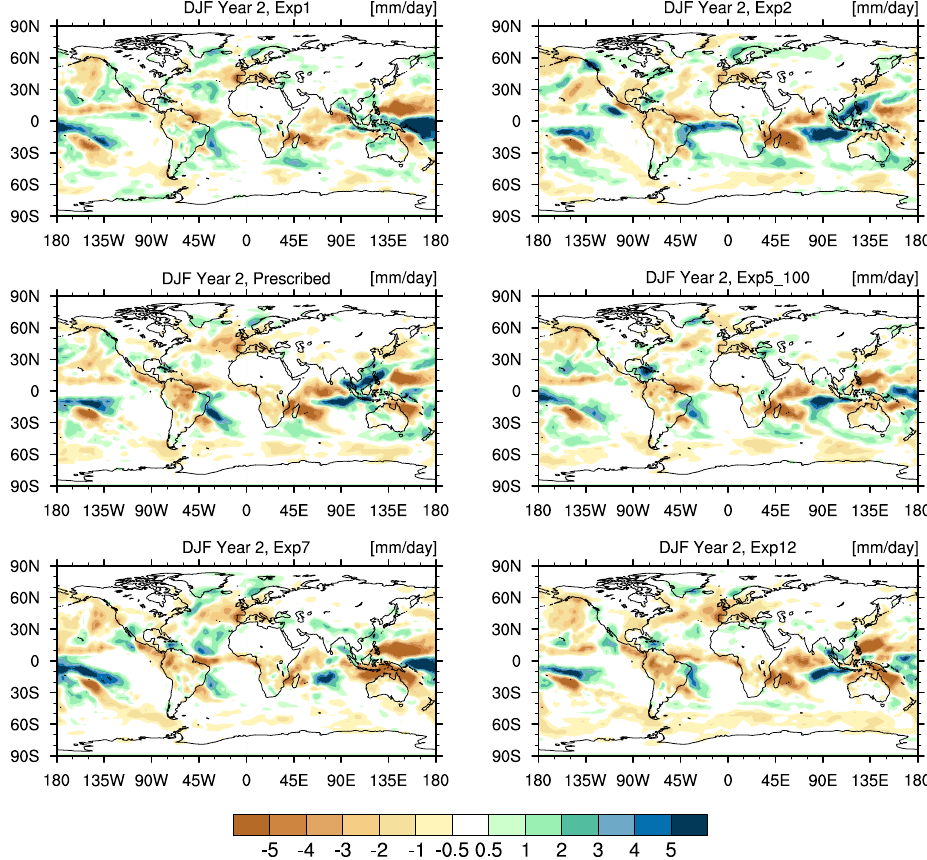
Fig. 12. Same as Fig. 11, but averaged for December, January, and February of the second